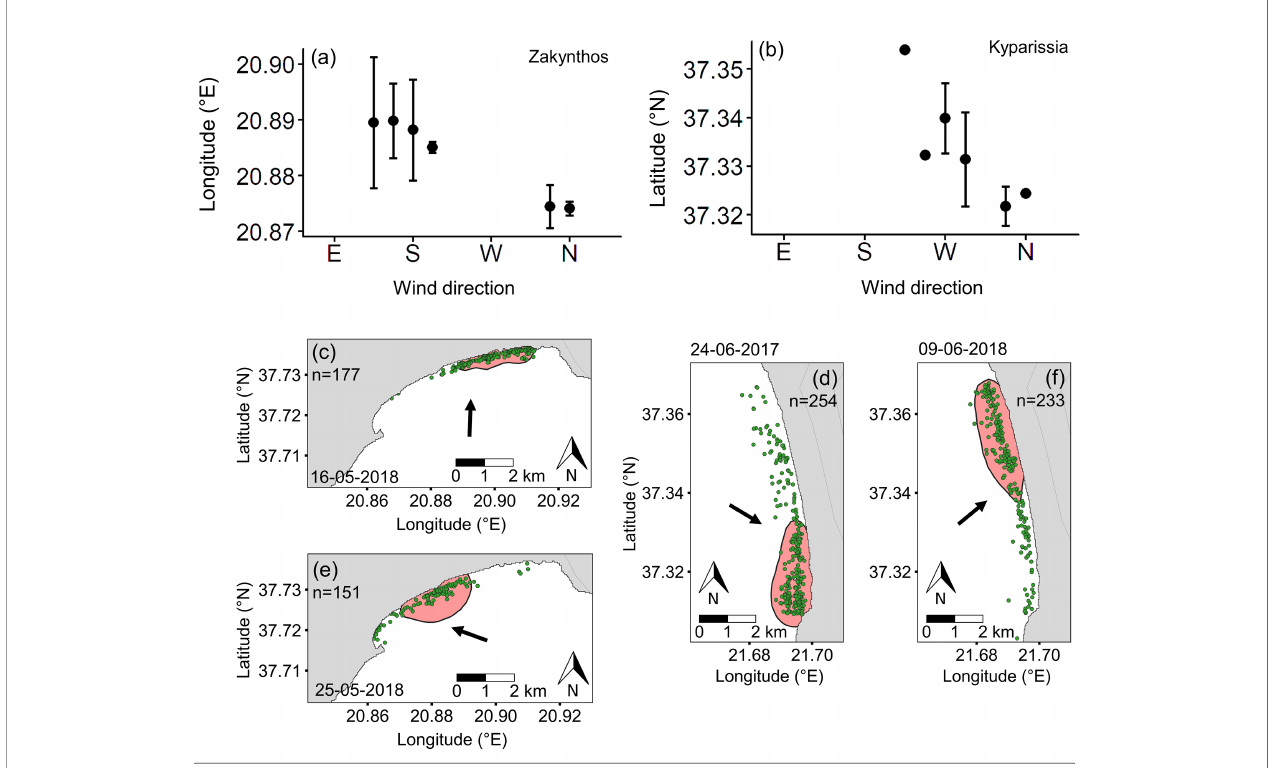
FIGURE 3 | (A, B) Wind-associated shifts in the fi ne-scale positioning of sea turtle aggregations (50% KUD centroid) along the 8-km coastal areas of Laganas Bay on Zakynthos Island (n = 3131 turtles on 27 days, F 1,25 = 16.18, P < 0.001 ) and Kyparissiakos Bay on mainland Greece (n = 3805 turtles on 18 days, F 1,16 = 10.64, P < 0.001 ) based on UAS surveys in 2017 – 2019. Examples show the 50% KUD (red shading) of sea turtle aggregations (green dots) on two days with different wind directions for (C, E) Laganas Bay and (D, F) southern Kyparissiakos